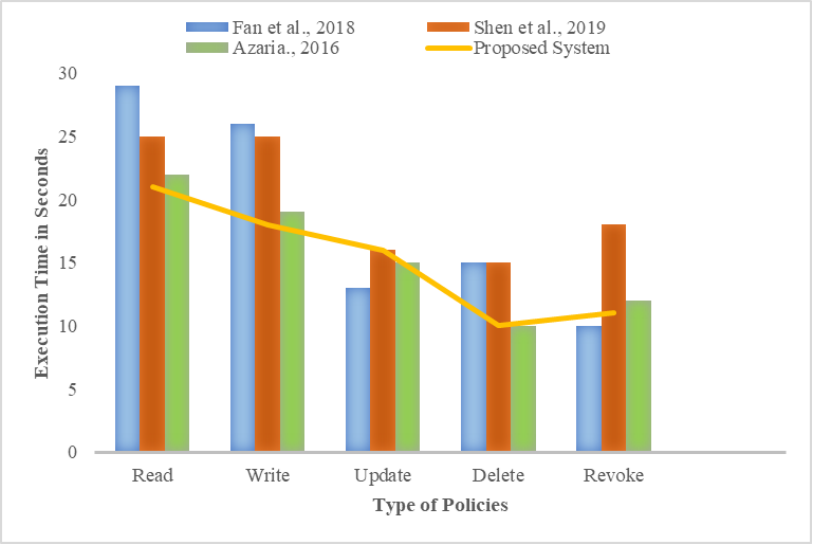
Figure 12. Comparison of policies with respect to execution time.